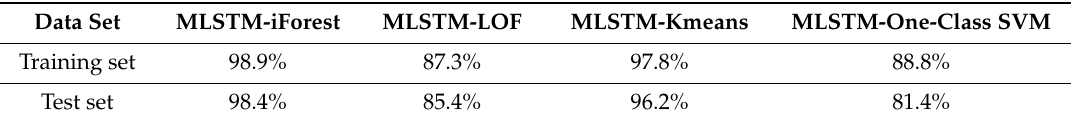
Table 3. Accuracy comparison of the unsupervised algorithm. MLSTM: Multilayer LSTM, LOF: local outlier factor, SVM: support vector